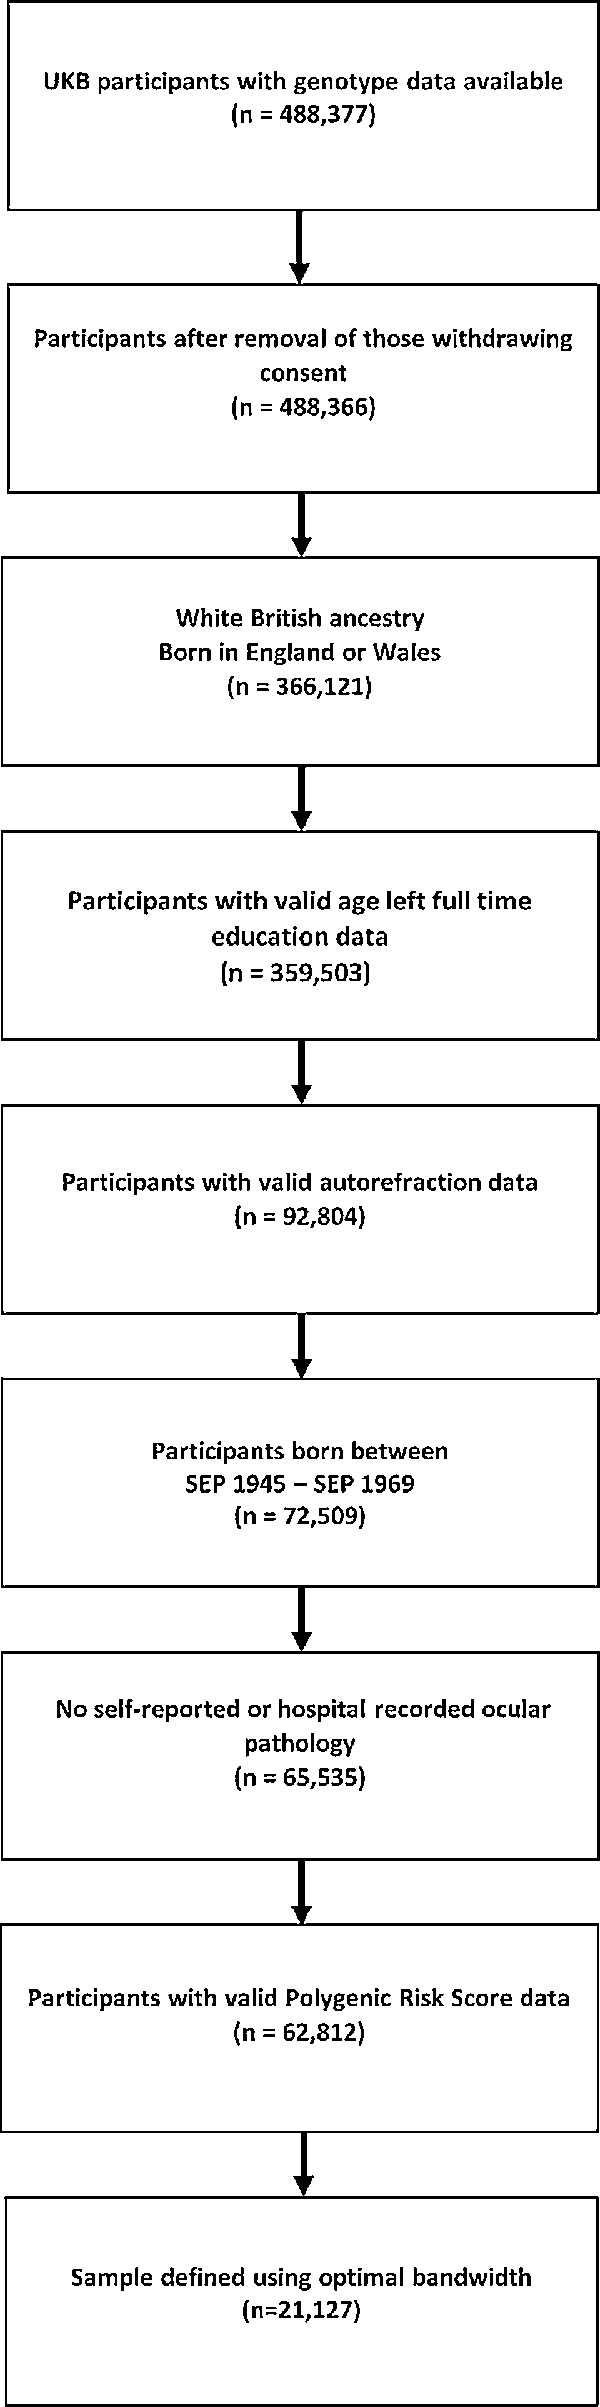
Flow diagram illustrating the selection of UK Biobank participants for the regression discontinuity analysis.